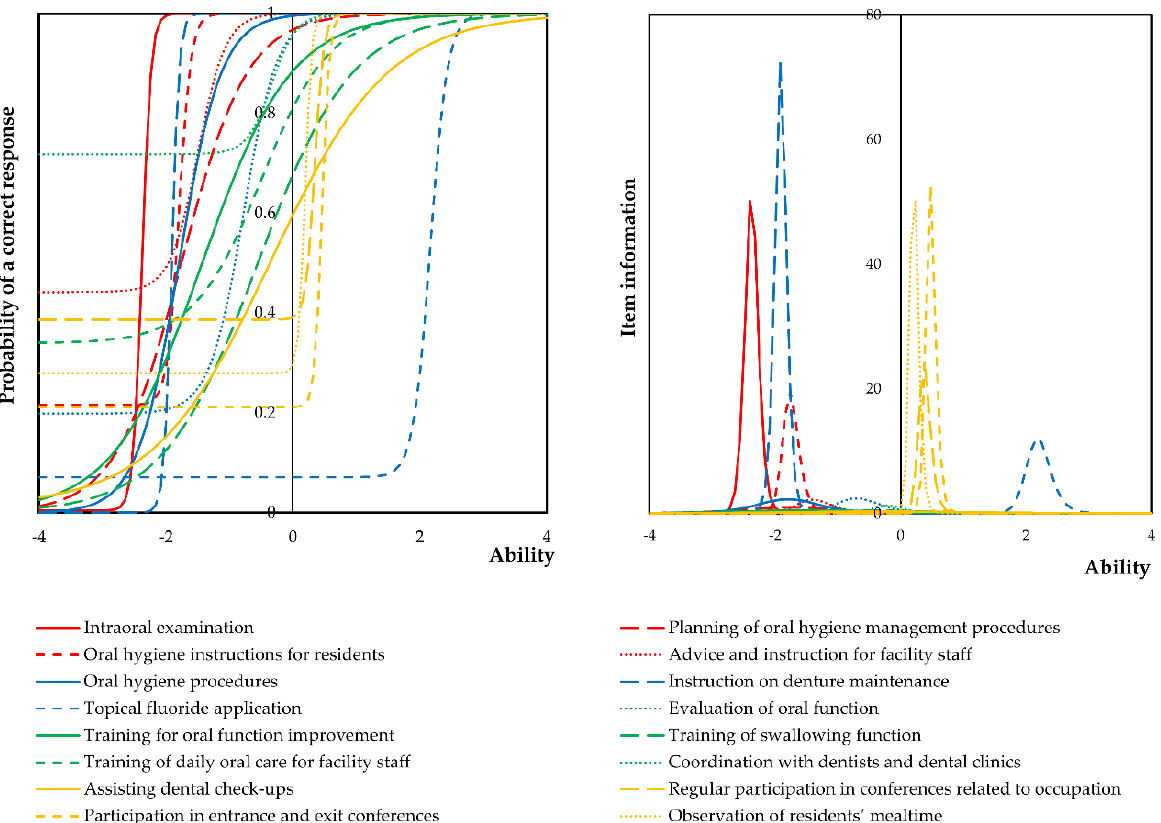
Figure 2. Item response curves and item information curves concerning items for daily tasks at nursing facilities. Ability, expressed as a scale on the X -axis, represents the weighted score of the total performance rate. An item response curve or item information curve in a backward direction indicates that the task corresponding to the item was frequently performed. In contrast, an item response curve in a forward direction indicates that the task corresponding to the item was rarely performed. Steep item response curves and high item information curves indicate that, when these tasks were implemented, other tasks were easily